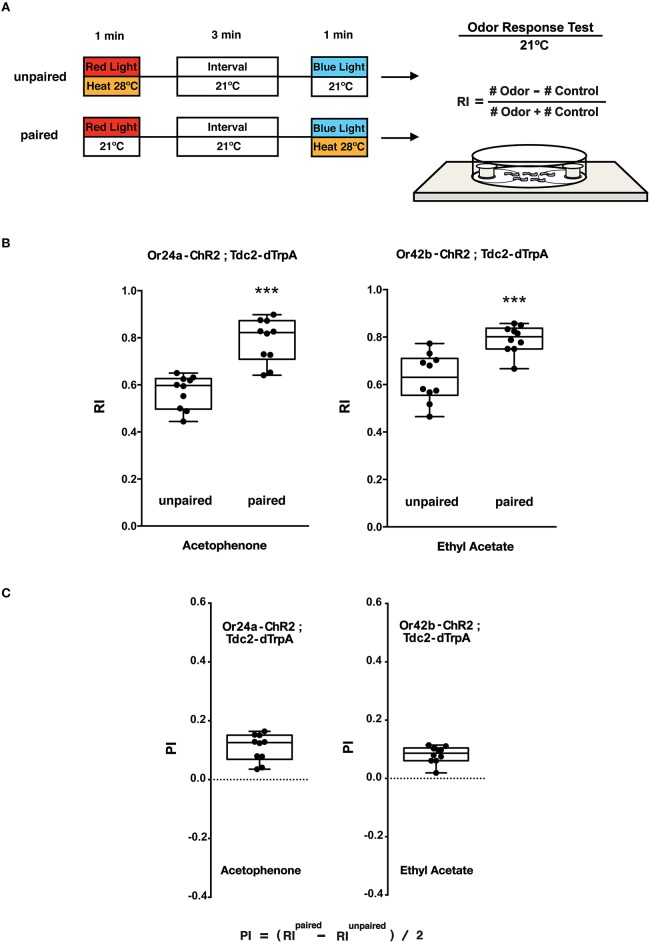
Olfactory response tests of larval memory formed with paired presentation of blue light and heat. (A) Larval conditionings and olfactory test. Transgenic larvae carrying both Or-ChR2 and Tdc2-dTrpA1 were conditioned with heat (28°C) and blue light in either unpaired or paired way as described in Figure 4A. Larval olfactory response was then tested at 21°C on the olfactory test plate. (B) Olfactory responses of transgenic larvae (Or-ChR2; Tdc2-dTrpA1) with unpaired and paired conditioning. The paired but not the unpaired conditioning with blue light and heat (28°C) caused significant increase in the olfactory response to the specific odorant determined by the Or-ChR2 type. ***p < 0.001 by Mann-Whitney U-test between unpaired and paired group. n = 10 trials. (C) Memory performance scores (PI) of the paired conditioning group against the unpaired control. Box plots represent the median as the middle line, 25th and 75th percentile as box boundaries, as well as the minimum and the maximum as whiskers, respectively.